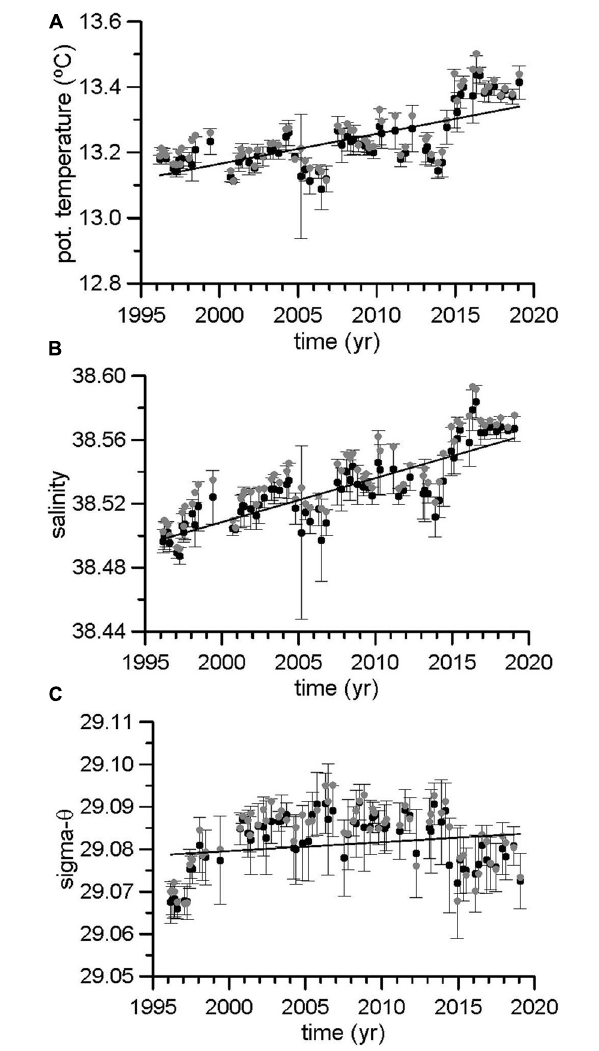
FIGURE 6 | Time series of potential temperature (A) , salinity (B) , and potential density (C) of the deep waters. Black dots and error bars (one standard deviation) correspond to properties obtained using method 1 (waters with a potential density higher than 29.11 kg/m 3 ) whereas gray dots and error bars correspond to properties obtained using method 2 (waters with potential temperature higher than 29.1 kg/m 3